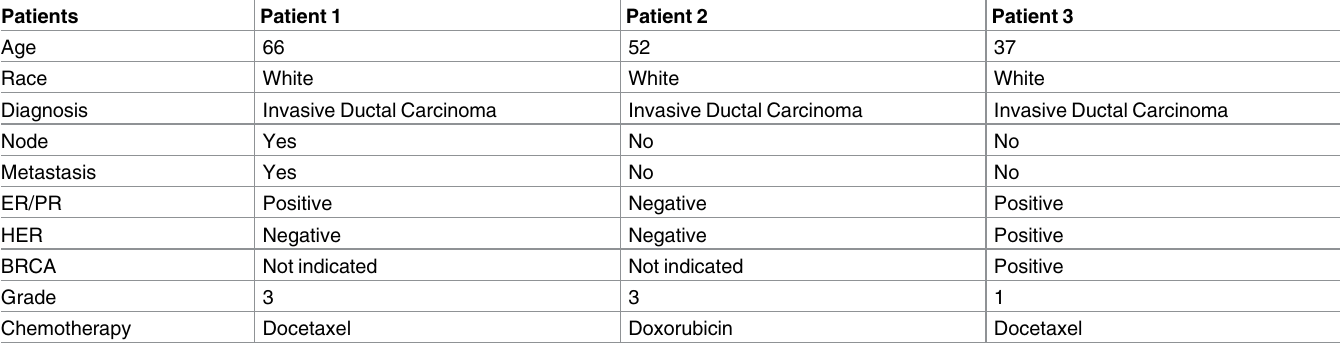
Table 1. Patient